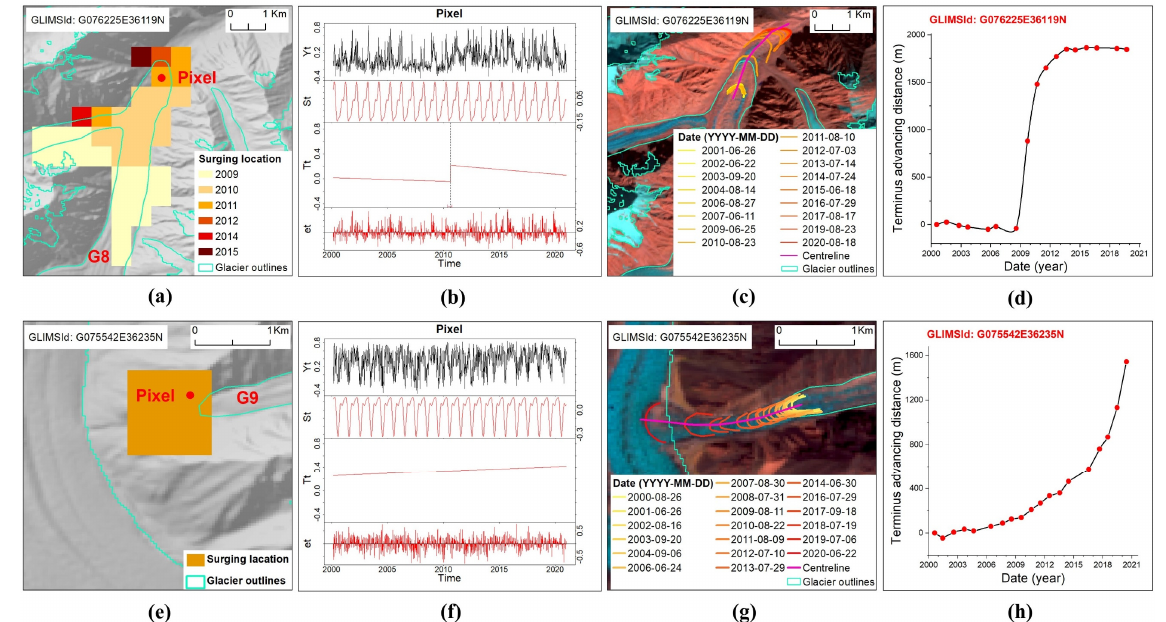
Figure 5. Examples of different types of surging on clean-ice glacier tongues. The GLIMS IDs for G8 and G9 are G076225E36119N and G075542E36235N, respectively. See Figure 1 for the locations of the two glaciers. ( a , e ) The locations and years of surge initiation; ( b , f ) the decomposed components of NDSI time series at the surge-affected pixel (red dots in ( a , e )); ( c , g ) the change in the terminus position over time; ( d , h ) the time series of the terminus-advance distance. The background images are false-color composites (band 6—SWIR1, 5—NIR, 4—Red as RGB) from Landsat 8 OLI acquired in 2020 in ( c , g ).